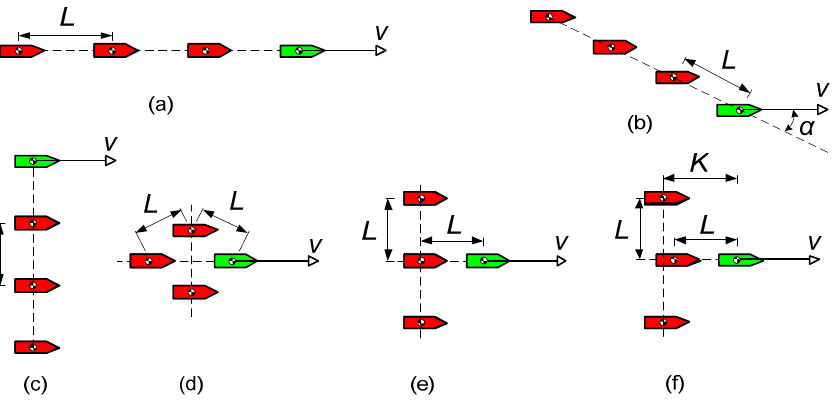
Figure 6. Considered formation shapes. ( a ) a linear shape, ( b ) an echelon shape with an angle of α , ( c ) a wide shape, ( d ) diamond-shaped, ( e ) arrowhead-shaped, ( f ) arrowhead-shaped with variable position of outside members.